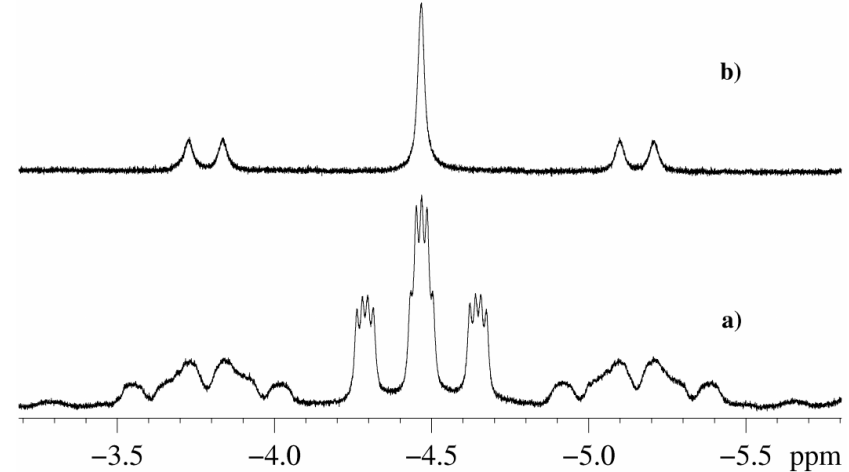
Figure 3. Portion of the 1 H ( a ) and 1 H{ 31 P} ( b ) spectra of 2 showing the hydride signal (C 6 D 6 , 298